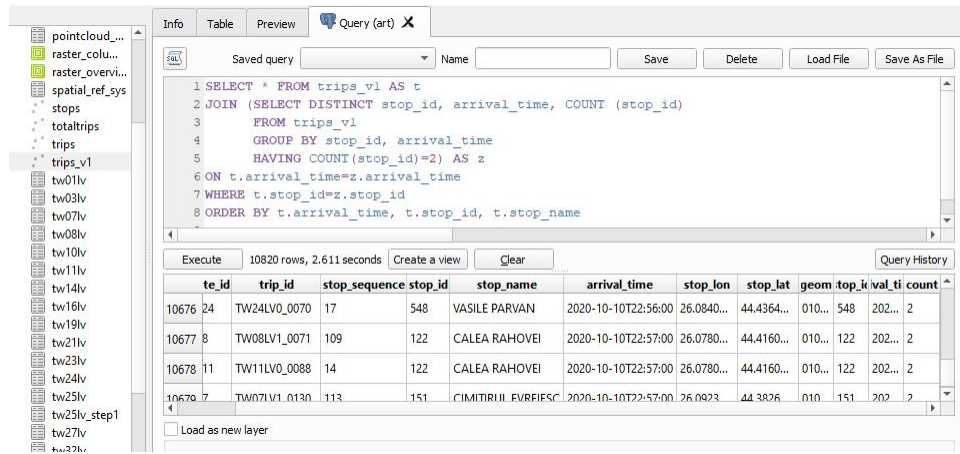
Figure 14. No. of vehicles arriving at stop_id 122 at the same time after changes of schedule.